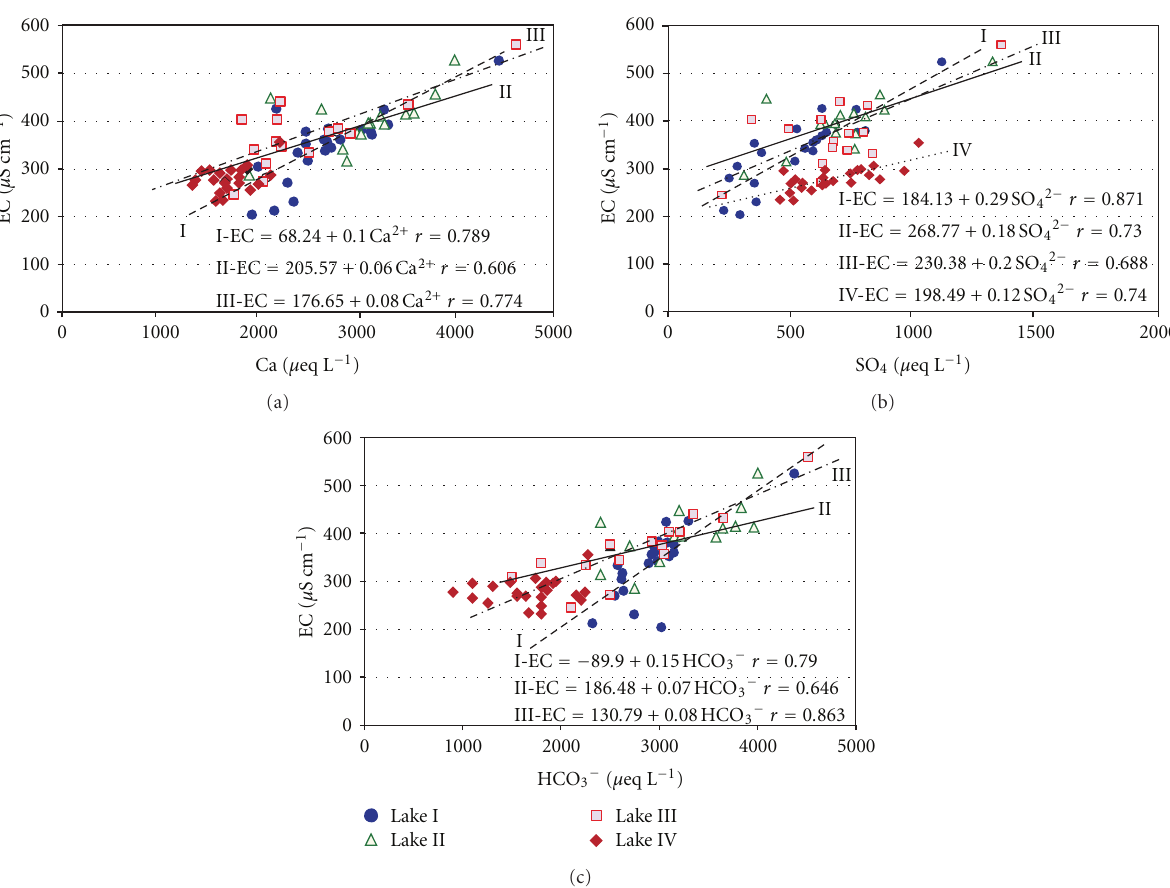
Figure 3: Relationships between specific electric conductivity EC and concentration of selected ions for tundra lakes with regression lines and equations: (a) Ca 2+ , (b) SO 42 − , and (c) HCO 3 −